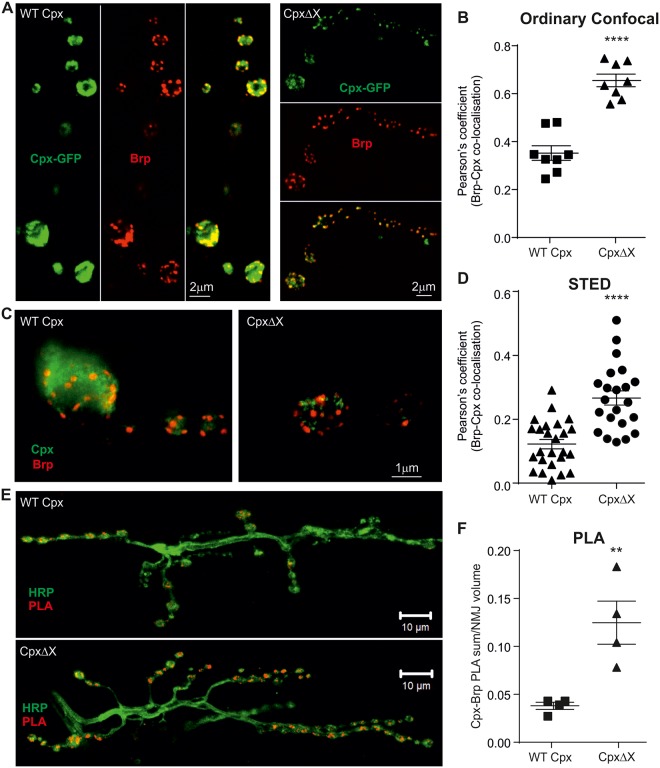
Lack of cpx farnesylation promotes its co-localization with AZs.(A) Representative maximal projection confocal images of GFP-tagged WT Cpx and mutant Cpx1257 (CpxΔX) at the NMJ (green: cpx, red: Brp). (B) Enhanced Cpx-Brp co-localization indicated by higher Pearson’s coefficient for CpxΔX (n–number of NMJs). (C) STED images showing cpx and Brp localization in single boutons in WT and CpxΔX mutants. The mutation (Cpx1257) increases the co-localization of cpx with Brp as indicated by the enhanced Pearson’s coefficient (D) (n–number of boutons). (E) Maximal projection confocal images of NMJs from larvae expressing WT Cpx and CpxΔX. PLA fluorescence shown in red and HRP staining in green. (F) Summated PLA signal volumes relative to NMJ volumes for cpx (GFP)-Brp interactions (n–number of NMJs). The raw data can be found in S6 Data. Data denote mean ± SEM, Student t test, **p = 0.009, ****p < 0.0001. AZ, active zone; Brp, Bruchpilot; cpx, complexin; GFP, green fluorescent protein; HRP, horseradish peroxidase; NMJ, neuromuscular junction; PLA, proximity ligation assay; STED, stimulated emission depletion; WT, wild-type.